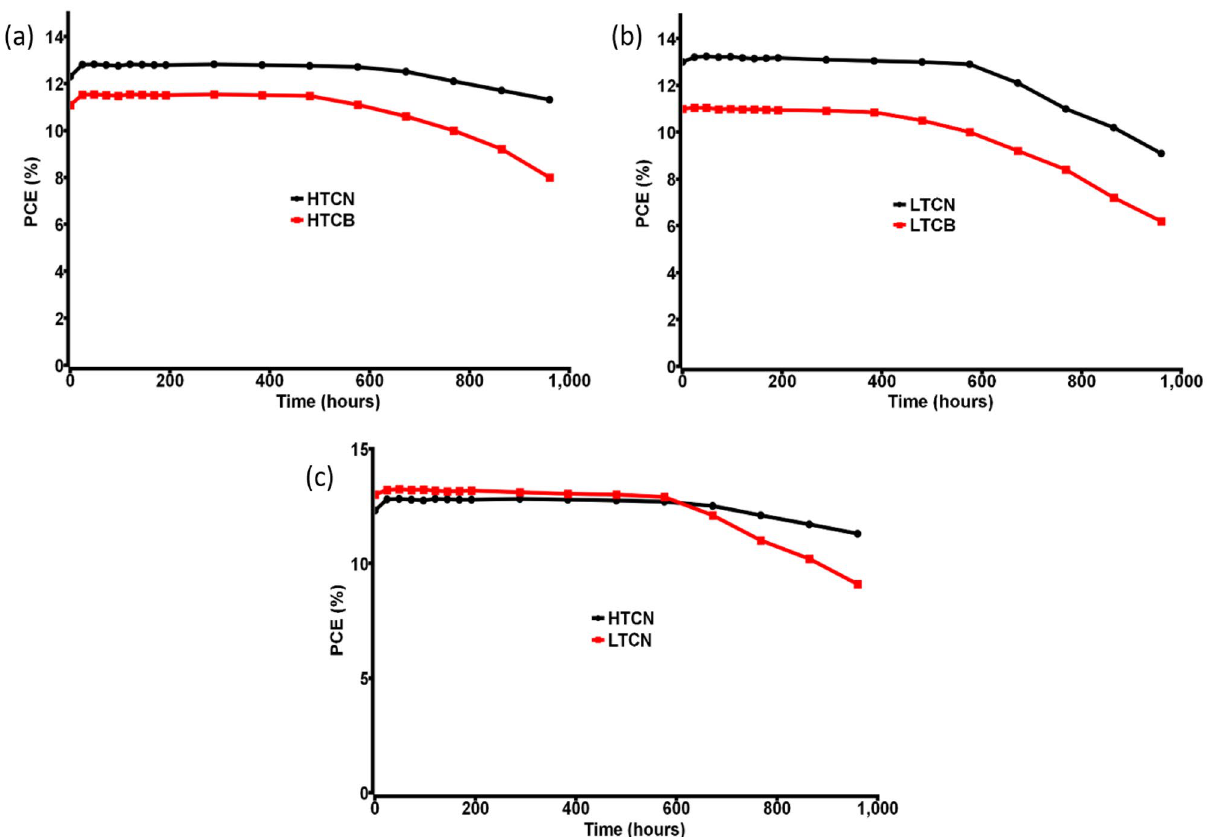
Figure 8. ( a ) Stability comparison between HTCN and HTCB devices, ( b ) stability comparison between LTCN and LTCB devices, ( c ) stability comparison between HTCN and LTCN